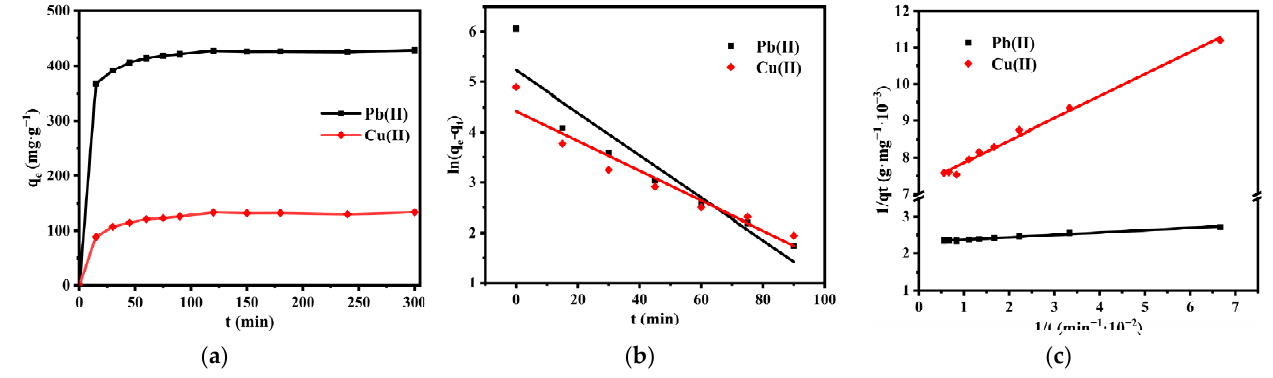
Figure 14. Effect of contact time on the removal of Pb(II) and Cu(II) ( a ); pseudo-first-order kinetics model ( b ); pseudo-second-order model ( c ). Table 8. The parameters of the pseudo-first-order and pseudo-second-order models.